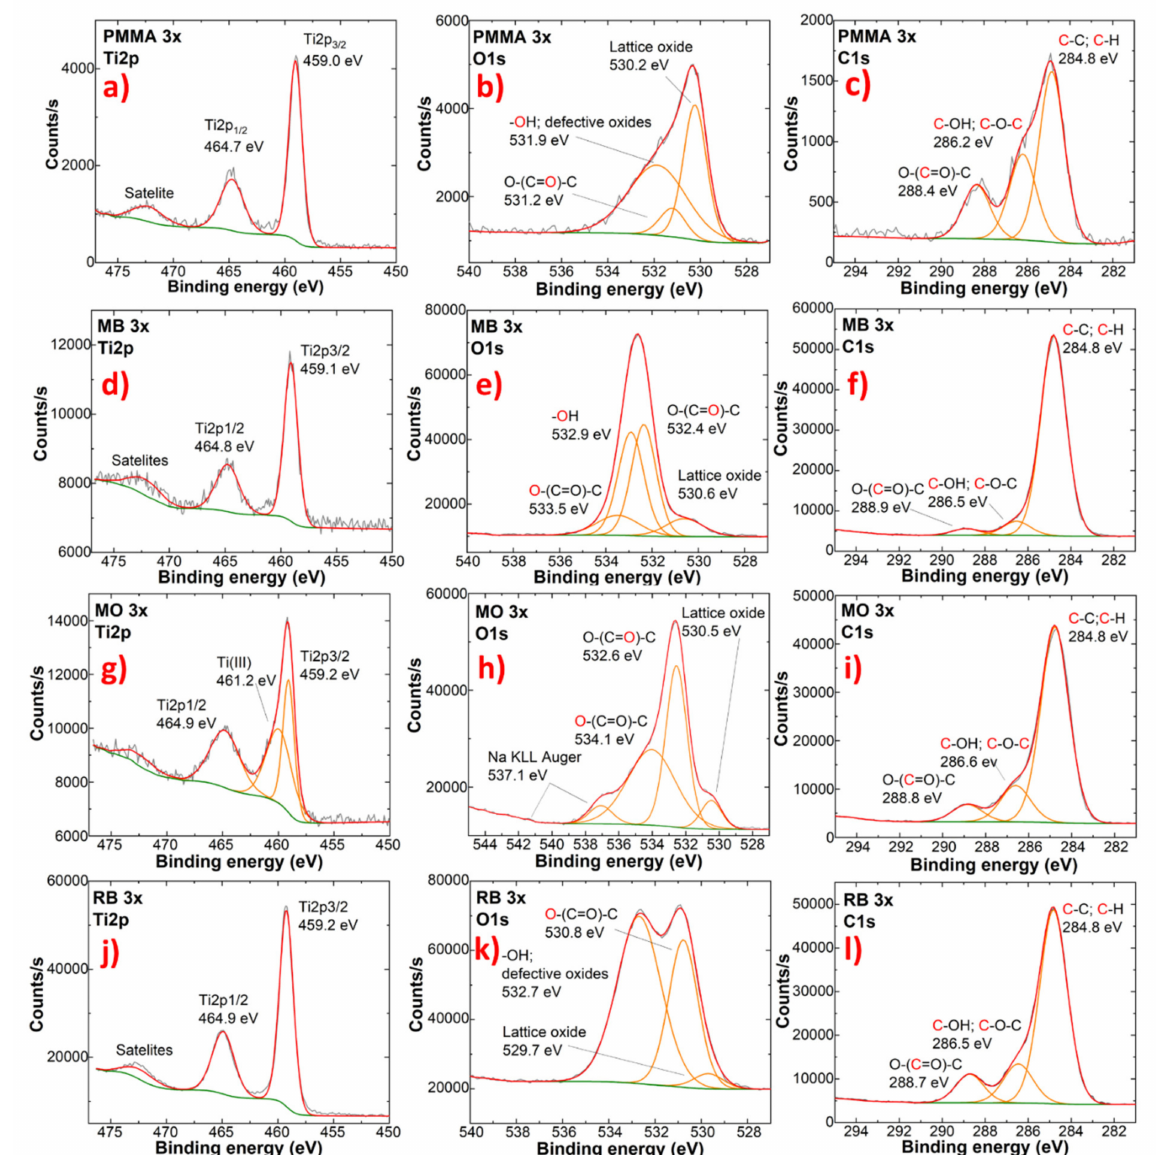
Figure 8. XPS measurements of high-definition scans of Ti 2p, O 1s, and C 1s spectra. ( a – c ) be- fore photocatalysis (PMMA samples) and after photocatalysis using ( d – f ) MB; ( g – i ) MO and ( j – l ) RB,